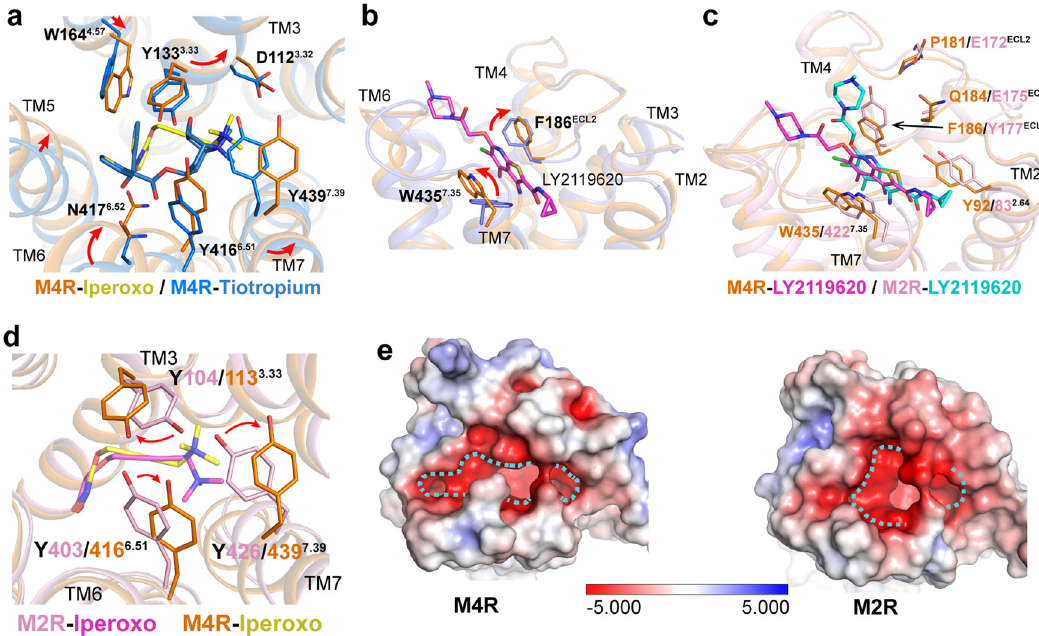
Fig. 2 Comparison of iperoxo and LY2119620 binding pockets in M4R and M2R structures. a Conformational changes of key residues within the orthosteric binding pocket in inactive M4R (PDB code 5DSG, blue) and active M4R (orange) structures. b Rotation changes of residues F186 ECL2 and W435 7.35 in the M4R – ip – LY – G i structure to form π – π interactions with LY2119620 compared to that of in M4R – ip – G i structure. c Comparison of LY2119620 binding pose, and d tyrosine lid between active M4R – ip – LY – G i and M2R – ip – LY – G oA (PDB code 6oik, pink) structures. e Electrostatic and shape properties of the LY2119620 binding site in active M2R and M4R structures. Negatively charged residues are colored as red. Dotted line delineates the shape of the allosteric binding